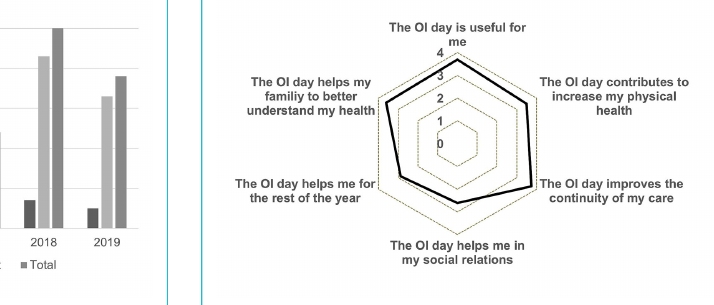
Figure 5: OI day quality related survey. Patients answered with a grading scale: 1 = extremely dissatisfied, 2 = somewhat dissatis- fied, 3 = somewhat satisfied, 4 = extremely satisfied.